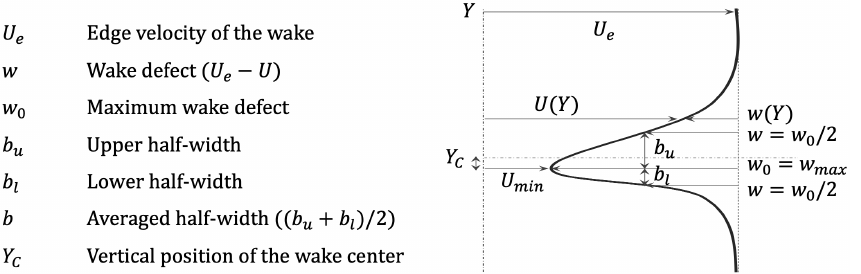
Figure 15. Wake half-width and velocity deficit nomenclature.